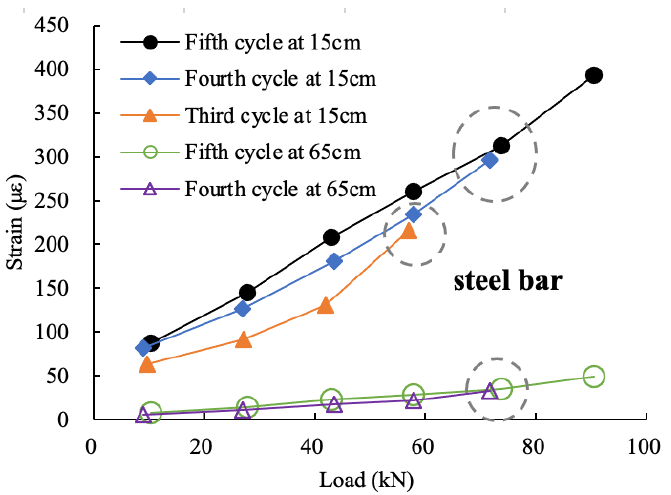
Figure 8. Strain-load relationship curve of the steel bar at 15 cm and 65 cm away from the zero point [23].